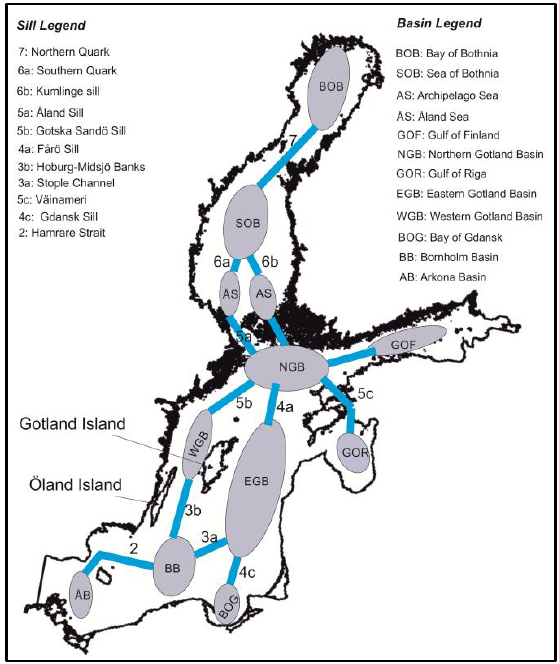
Figure 2. The Baltic Sea basin system, redrawn from an interpolated figure by Leppäranta & Myrberg [7].